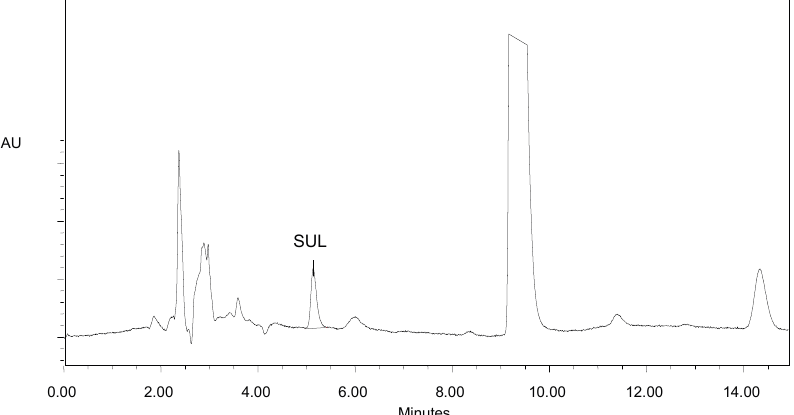
Figure 3. Chromatogram of a soil sample contaminated with sulfentrazone (SUL), highlighting the peak of the analyte.